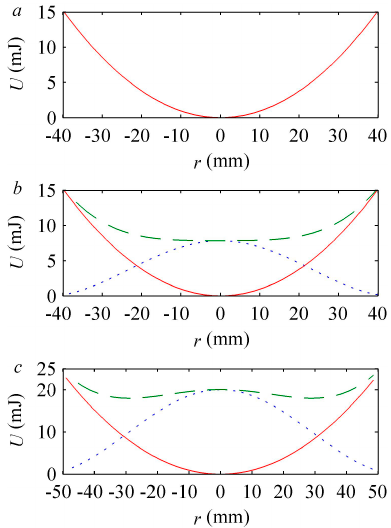
Figure 4. Static mechanical potential energy for a loading spring pretension of ( a ) 0.01 mm, ( b ) 1.25 mm and ( c ) 2 mm. The quadratic restoring potential of the beam (thin solid line) and the nonlinear potential of the loading spring (dotted line) are added to give the total potential energy (dark solid line) as a function of the tip